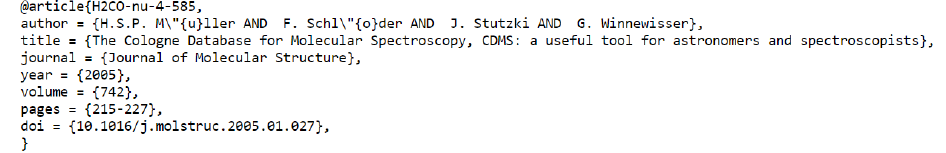
Figure 2. An excerpt of the bibliography for the isotopologue H 12 line-by-line section of HITRAN online . Every reference includes two hyperlinks at the end of each line that will take the user to the full-text article on the publisher’s website or ADS, respectively.